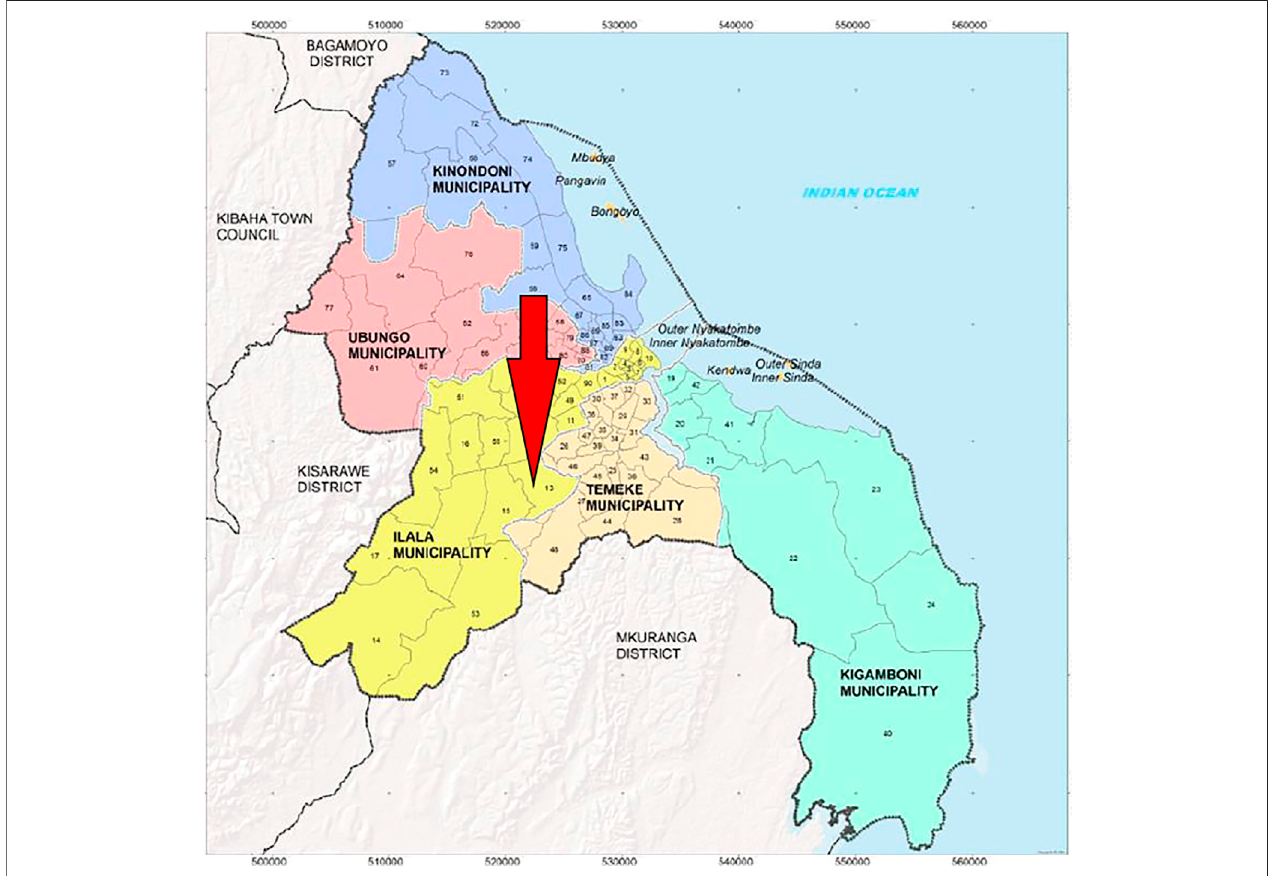
FIGURE 1 | Location of Keko Machungwa within Dar es Salaam City (red arrow mark). Source: Draft Dar es Salaam Master Plan (2016 –